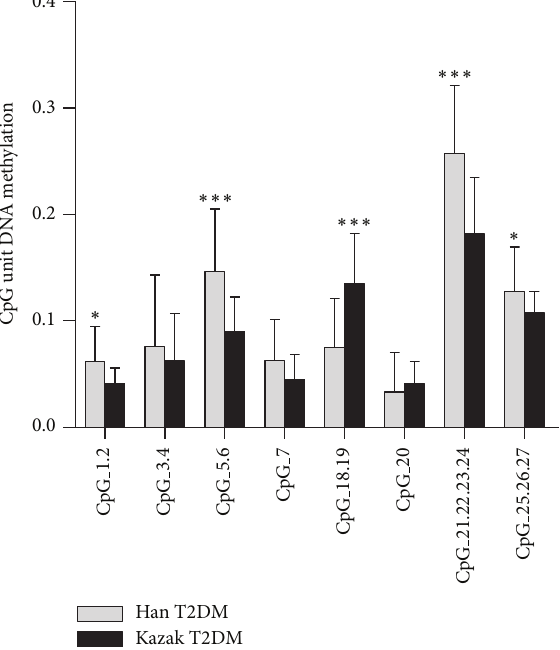
Figure 5: Comparison of specific miR-375 CpG methylation in Kazak and Han T2DM samples. The average methylation levels of specific CpG units of amplicon from 100 samples in each T2DM groups were determined by MassARRAY EpiTyper. ∗∗∗ 𝑃 < 0.001 and ∗ 𝑃 < 0.05 . The error bars represented standard